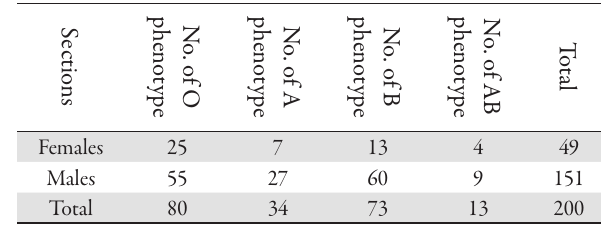
analyzedTab. Tab. 4. Gender wise distribution of ABO blood group among Koari population